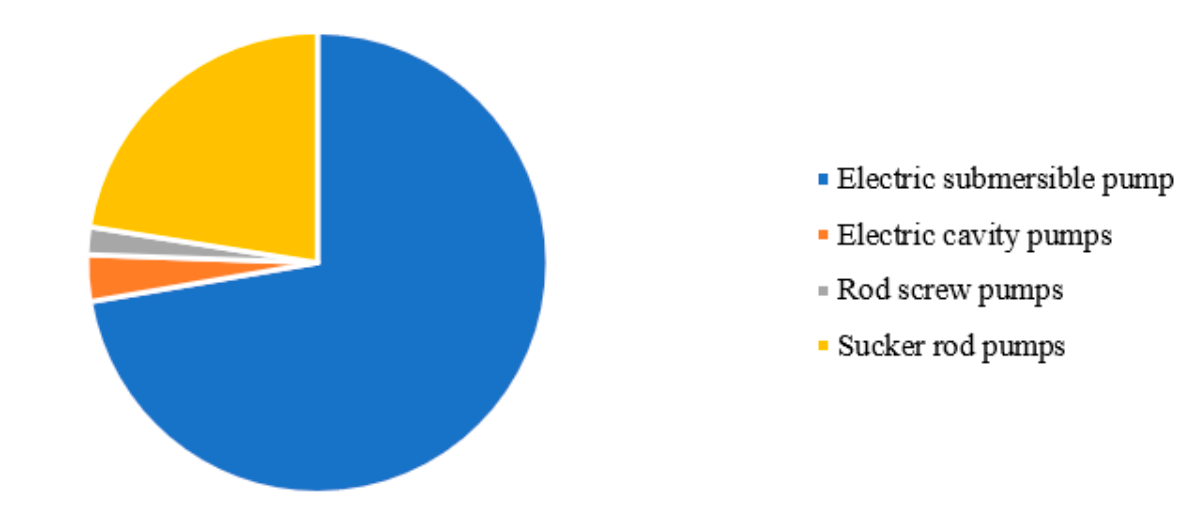
Figure 1. Distribution of the mining fund by the method of operation.